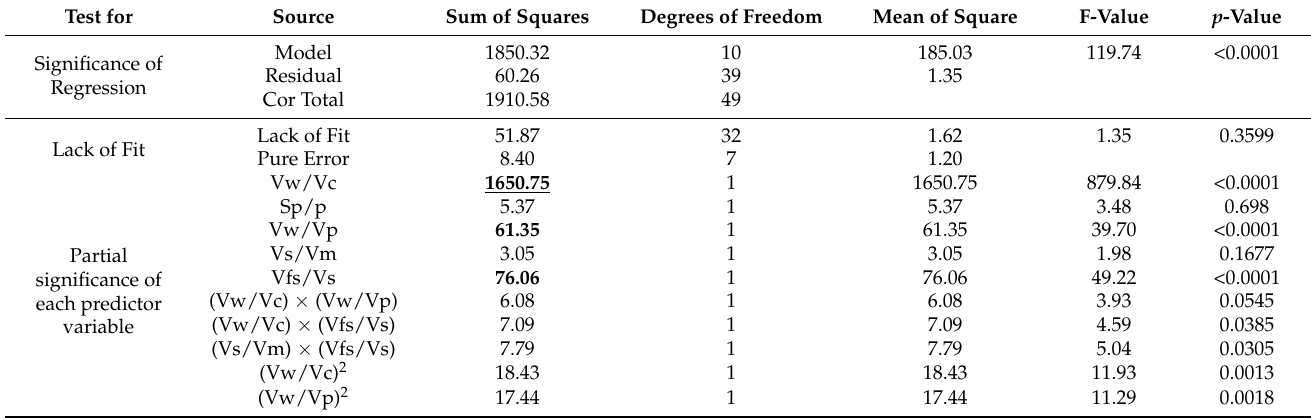
Table 11. ANOVA results for the Rc,24 h response.